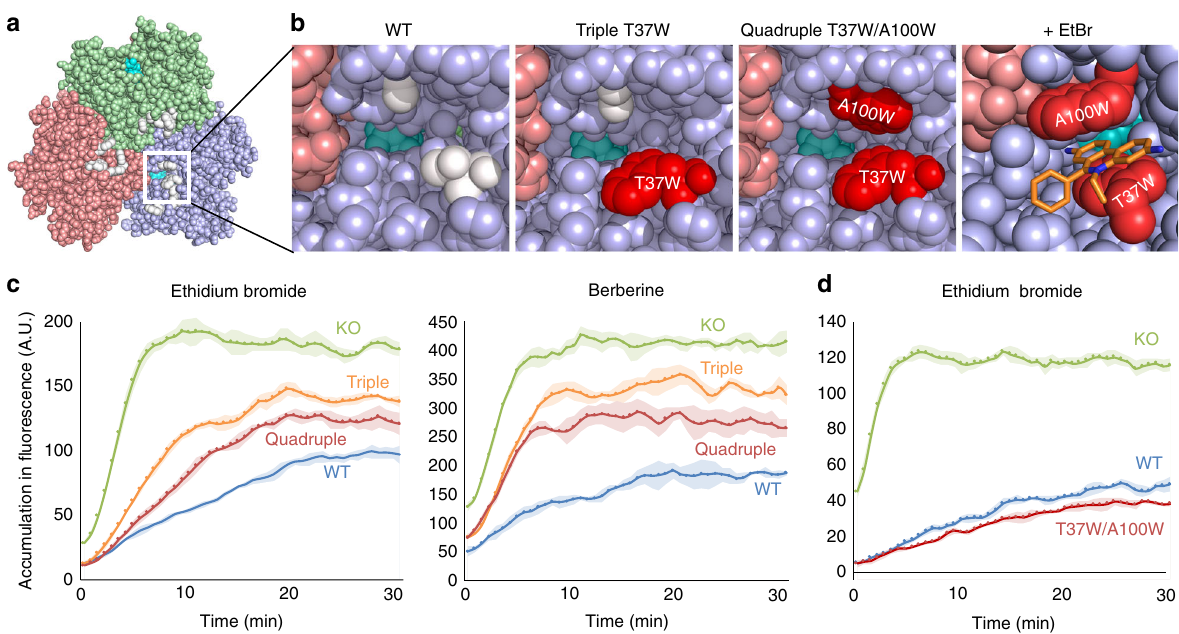
Fig. 2 Effect of the combination of the T37W and A100W mutations on the EtBr and BER export activity. a Vertical upward view on the bottom of the porter domain of AcrB (the transmembrane domain is removed for a clear view). Green: access monomer, pink: extrusion monomer, blue: binding monomer. The mutated residues A33W, T37W, A100W and N298W are shown in white. The white box indicates the zoomed area used for the panels. b Zoomed images around the central cavity channel (CH3) entrance in the binding monomer, focused on the T37 and A100 mutation points. The DBP-bound drug minocycline is shown in cyan and is partially visible. T37W and A100W mutations are shown in red. Intercalated ethidium is shown in orange. Docking simulations were calculated by Glide (Schrödinger Suite) 42 . The images were created by PyMol. c and d Accumulation assays for wild-type and mutant AcrB. EtBr and BER fl uorescence assays for triple (orange) and quadruple (red) mutant AcrB-expressing E. coli cells. Wild-type (WT, blue) and Δ acrB cells (KO, green) are also used as a control c . EtBr ef fl ux assay for T37W/A100W double mutant (red) and wild-type (WT, blue) AcrB wild-type. Δ acrB results (KO) are shown in green d . Supplementary Fig. 5 also shows the export ability of T37W/A100W double mutant and wild-type AcrB. The average data points and the ± standard deviations shown by the error-envelopes are derived from four independent experiments ( n = 4). The vertical axis shows the accumulation fl uorescence in arbitrary units (A.U.). WT wild-type, KO acrB